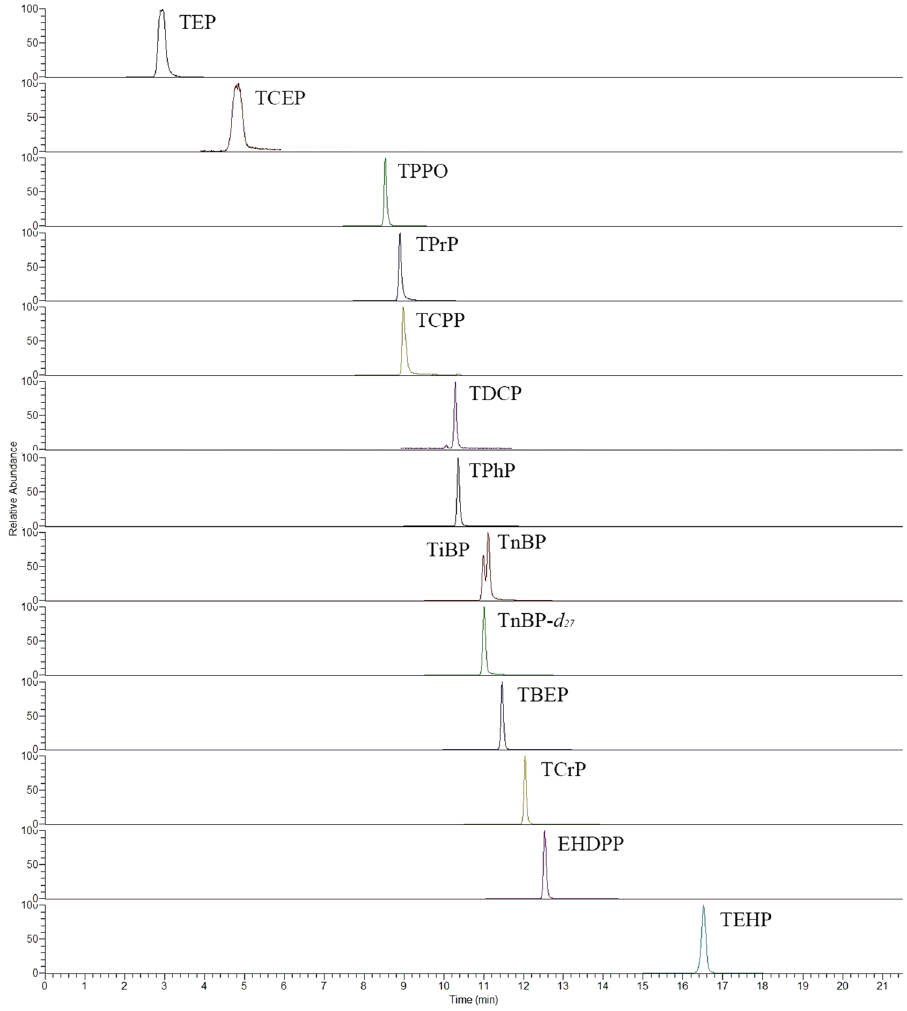
Figure 9. UHPLC-MS/MS chromatograms of 13 OPEs obtained for the spiked aqueous samples (1 µ g/L) using the SD-DLLME-SFO